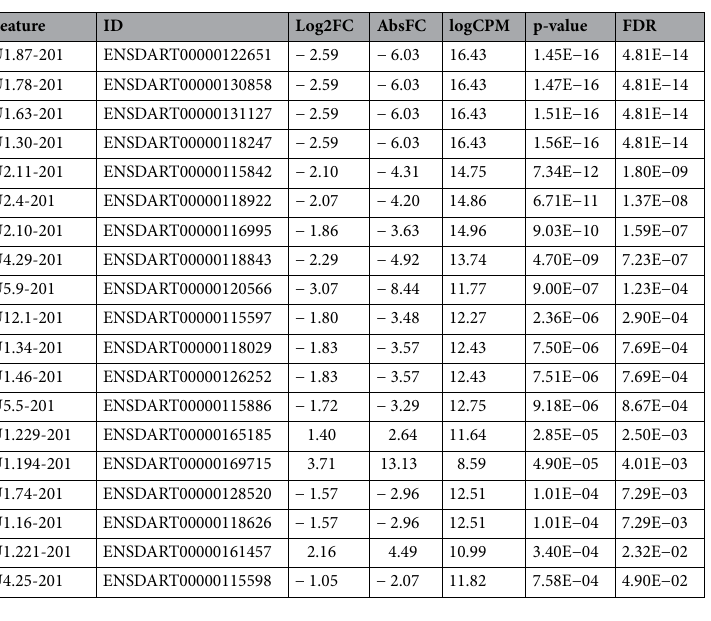
Table 5. Differentially expressed snRNAs. Pairwise comparison between generations F 1 from exposed (8.7 mGy/h γ-radiation) (F 1 -γ) and control parents (F 1 -C). Transcript IDs were obtained from Ensembl database (http://www.ensem